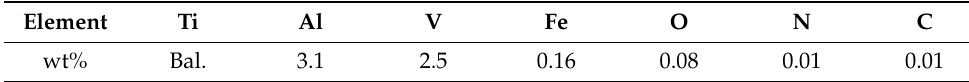
Table 1. Chemical composition of Ti-3Al-2.5V titanium alloy ingot.